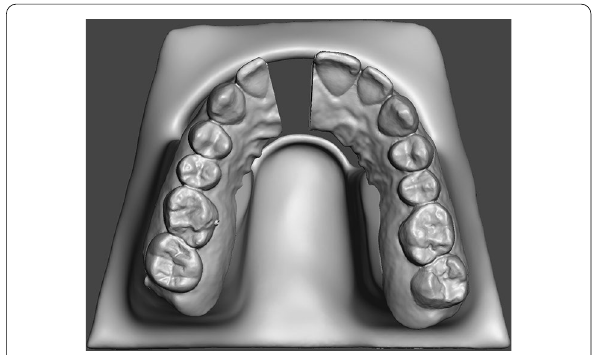
Fig. 2 Design of the test model, note no attachments are present on the model